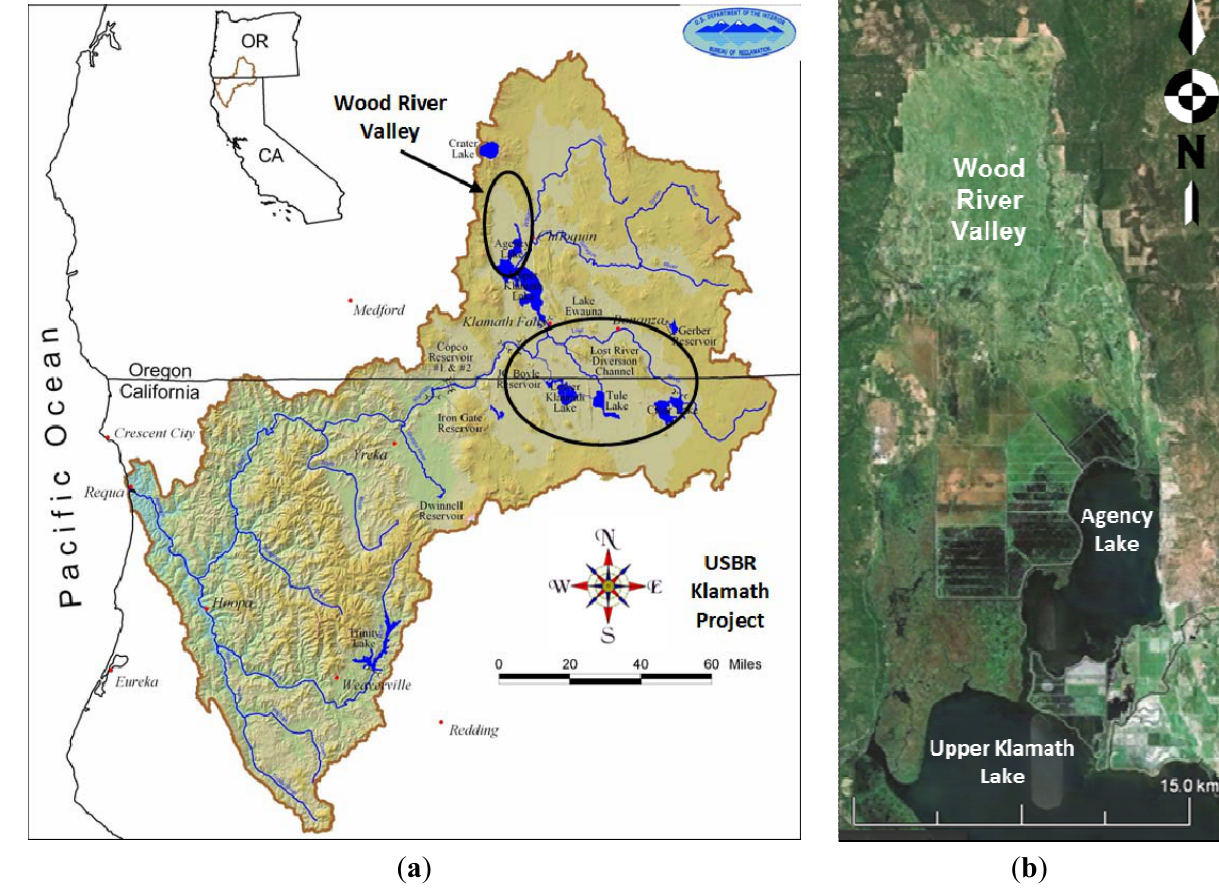
Figure 1. ( a ) Project location within the Klamath River Basin on the border between California and Oregon; ( b ) Aerial view of Wood River Valley which extends from 42.5306°N to 42.7495°N in North-South direction and from 121.9282°W to 122.0924°W in the East-West